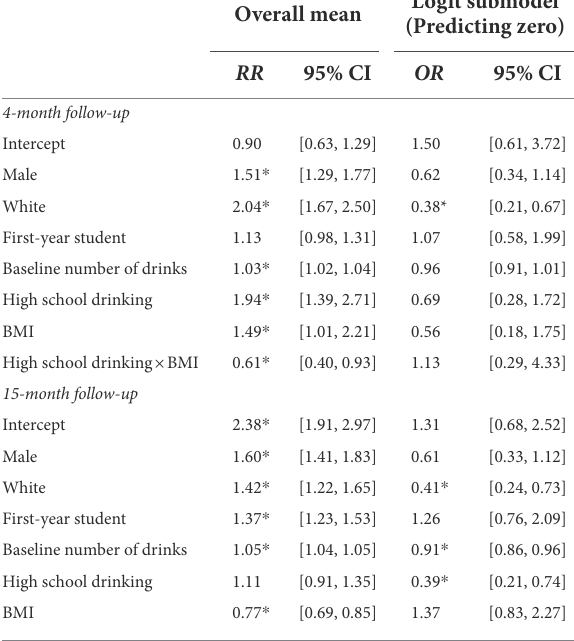
TABLE 2 Predicting the number of drinks in a typical week using MZIP models. Overall mean